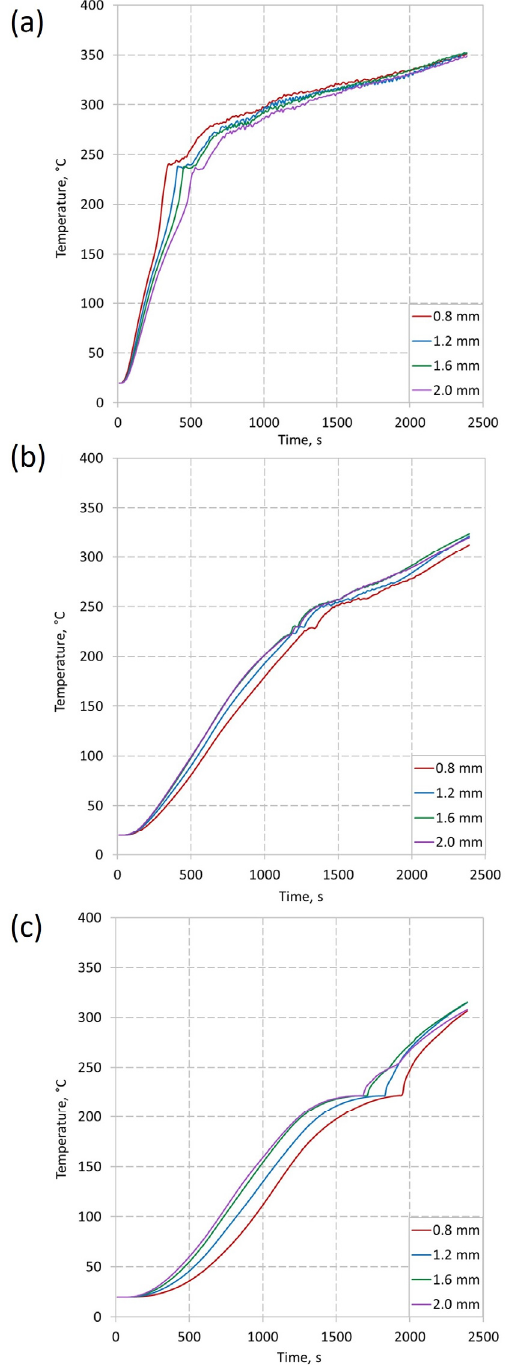
Figure 9. Calculated temperatures evolution on three different heights, for four thicknesses of the insert: ( a ) h = 12 mm; ( b ) h = 50 mm; ( c ) h = 87 insert: ( a ) h = 12 mm; ( b ) h = 50 mm; ( c ) h = 87 mm.